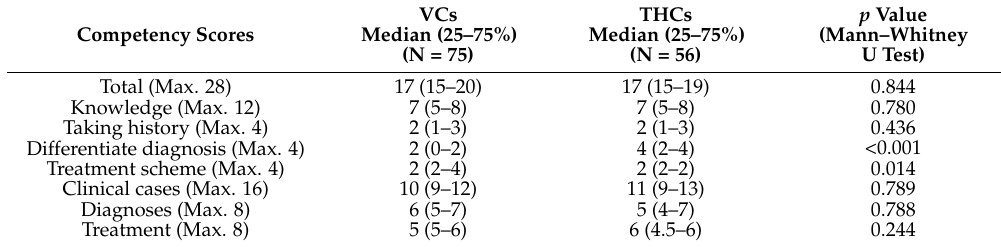
Table 4. Comparison of competency between village clinics and township health